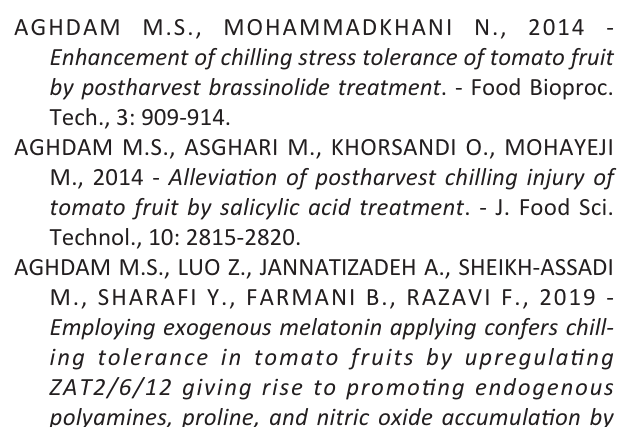
Table 3 ­ Melatonin treatments (0, 10, 100 and 1000 μmol L ­1 ) effects on phospholipase D (PLD) and lipoxygenase (LOX) in guava fruit during storage at 10°C for up to 21 days